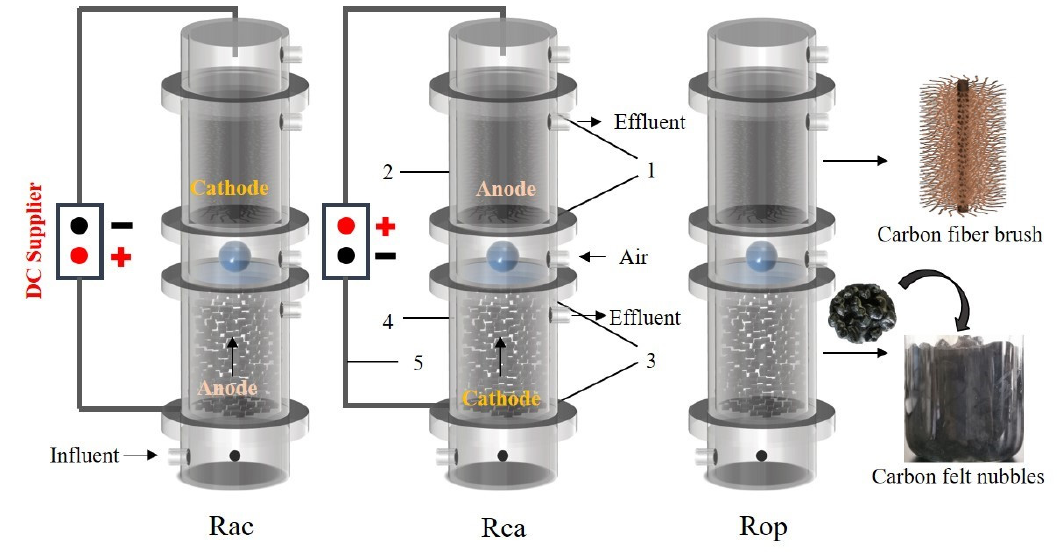
Figure 1. Schematic diagram of the experimental reactors (Rac: anaerobic anodic/aerobic cathodic chamber; Rca: anaerobic cathodic/aerobic anodic chamber; Rop: control reactor with open circuit). 1, titanium mesh (screen mesh size of 5 mm × 5 mm); 2, carbon fiber brush; 3, titanium mesh (screen mesh size of 2 mm × 2 mm); 4, carbon felt nubbles; 5, titanium plate.